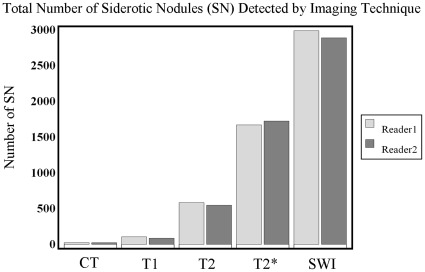
Total number of siderotic nodules (SN) detected by imaging technique for both readers.The total number of siderotic nodules detected by imaging for all patients by two independent readers. Different imaging methods are represented on the horizontal axis. The number of detected siderotic nodules is represented on the vertical axis. Light gray: results for reader 1. Dark gray: results for reader 2.